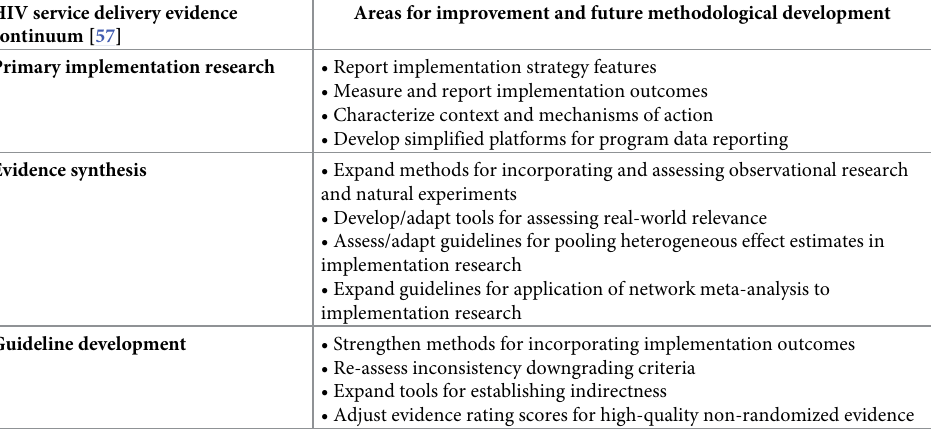
Table 3. Recommendations and areas for future methodological development to address evidence generation, synthesis, and guideline development challenges relevant to HIV implementation